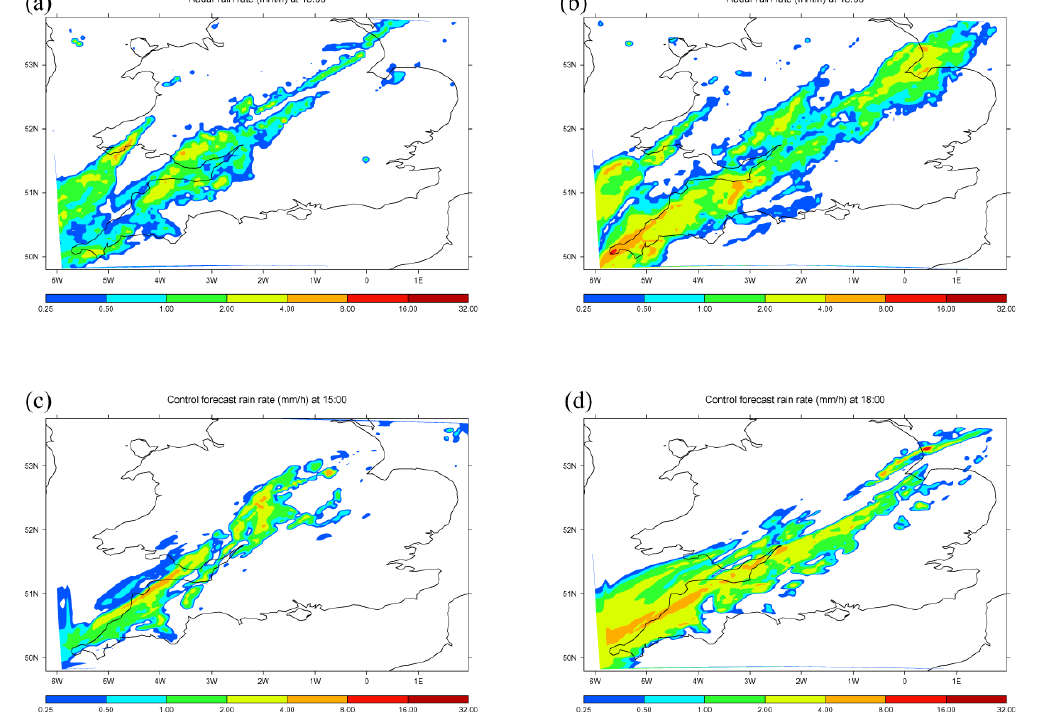
Fig. 5. Observed and model rain rate (mmh − 1 ). Left column: 15:00UTC ( T + 3), right column: 18:00UTC ( T + 6) 20 September 2011. Top row: radar-derived surface precipitation rates (1km composite), bottom row: control forecast rainfall rate at the